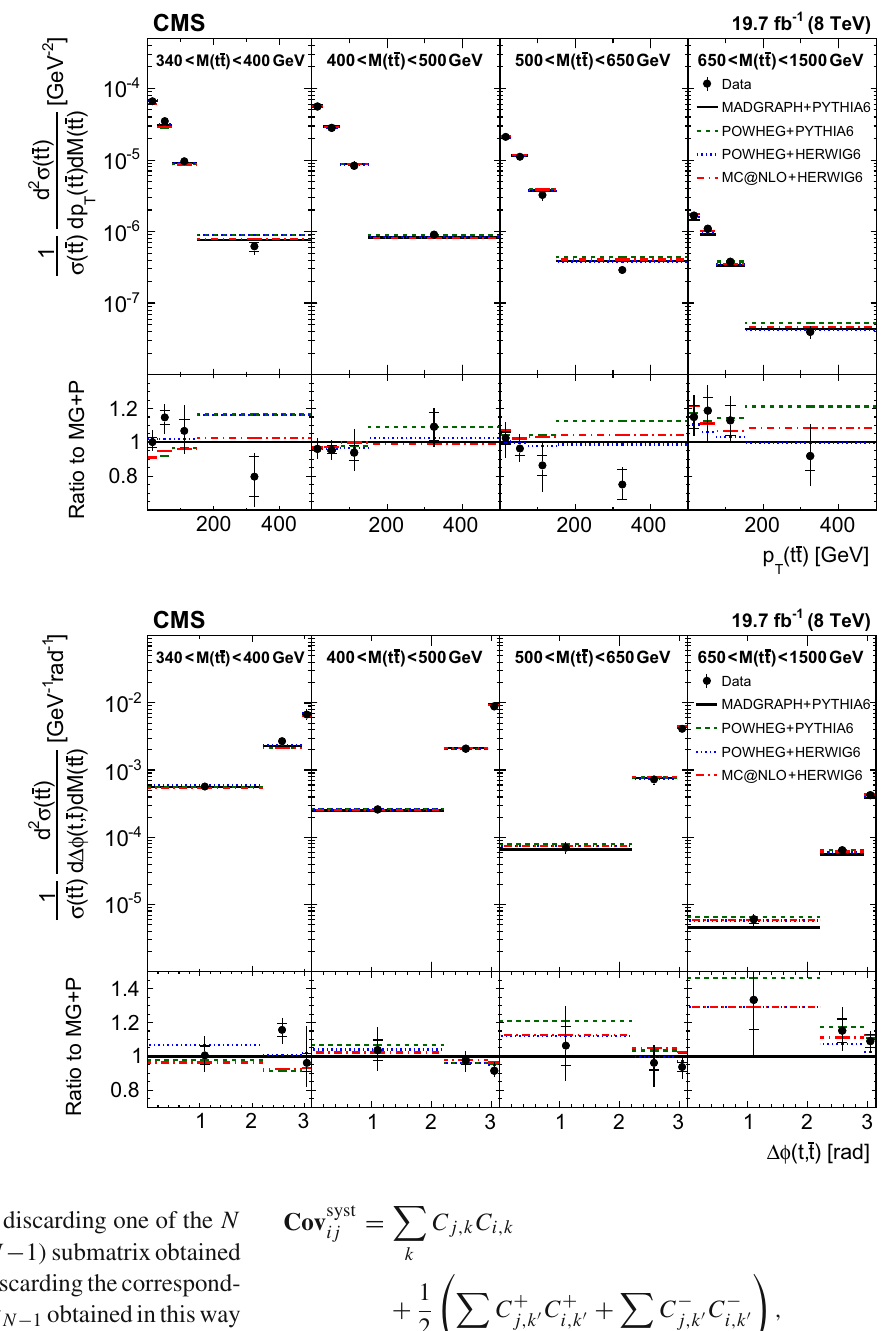
Fig. 6 Comparison of the measured normalized tt double-differential cross section as a function of p T ( tt ) in different M ( tt ) ranges to MC predictions. Details can be found in the caption of Fig. 2